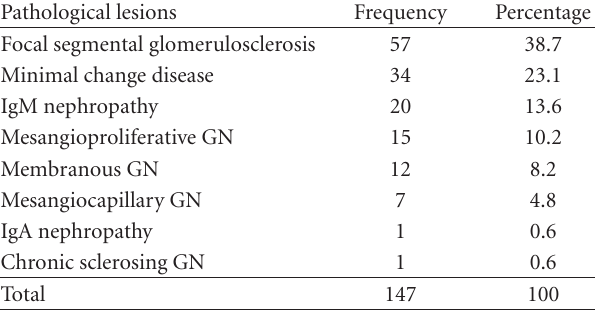
Table 2: The frequency distribution of di ff erent histopathological lesions in 147 pediatric patients with steroid-resistant nephrotic